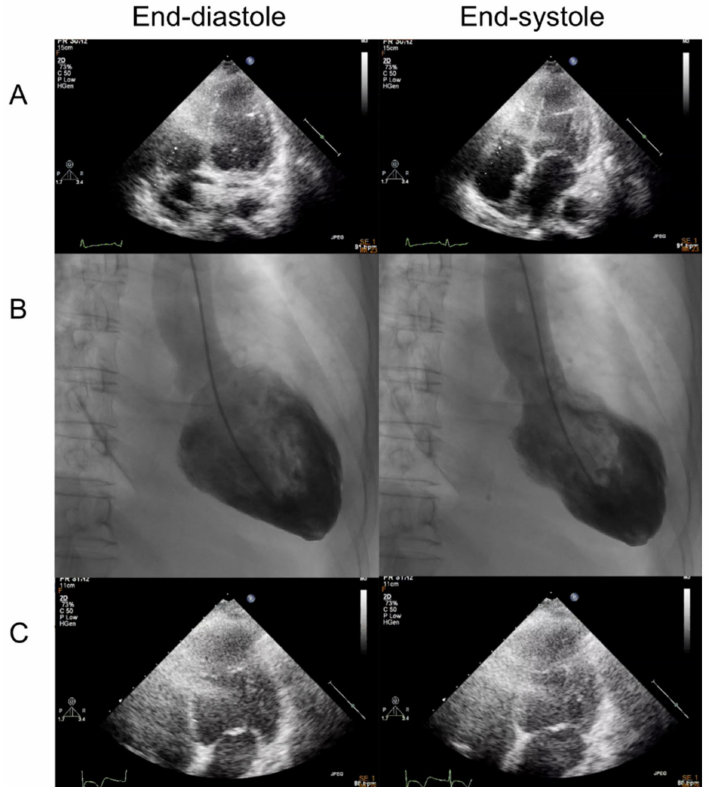
Figure 2. Left ventriculogram and serial echocardiogram of Takotsubo syndrome occurring after COVID-19 mRNA vaccination. ( A , B ) Echocardiography (four-chamber images) and left ventriculog- raphy at the presentation of Takotsubo syndrome after COVID-19 mRNA vaccination. ( C ) Repeat echocardiography (four-chamber images) revealed an improvement in apical ballooning on day 6. Notice the slow recovery of the negative T wave during the subacute phase (left panel: end-diastolic phase, right panel: end-systolic phase).